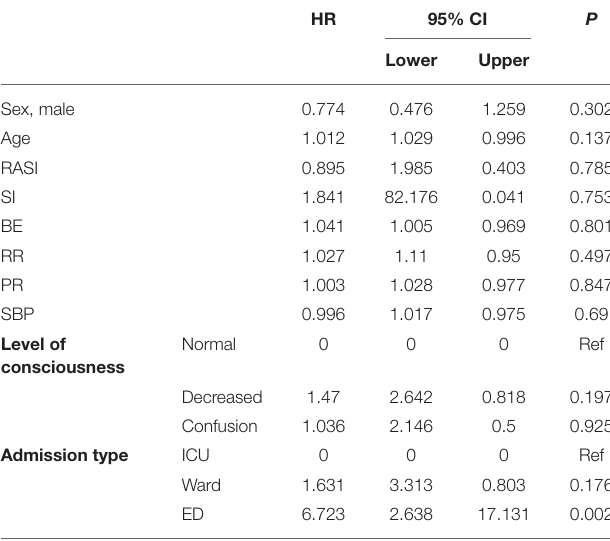
TABLE 4 | Relationship between demographic variables and